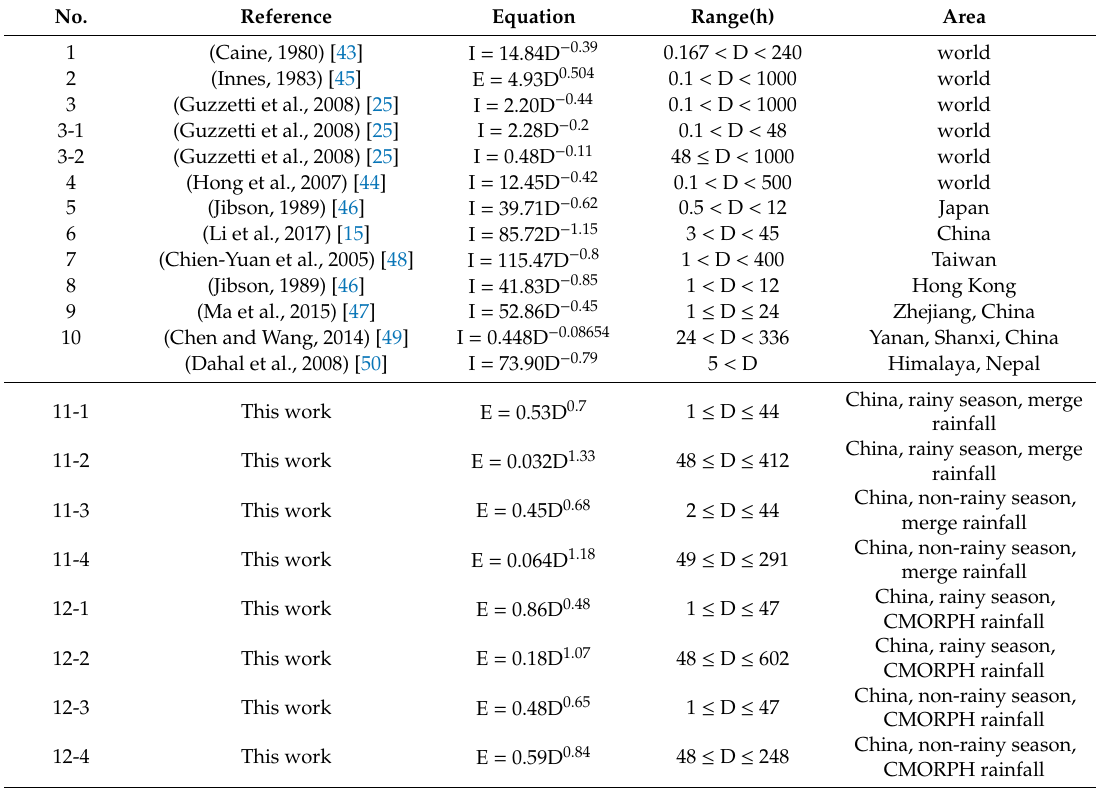
Table 4. Rainfall thresholds for landslide occurrence in this work compared with those in previous publications.